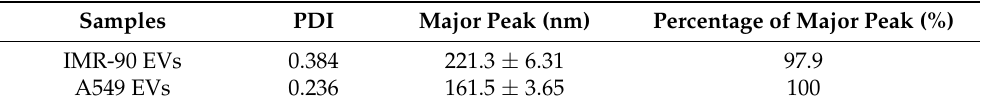
Figure 2. Characterization of EVs secreted by IMR-90 cells and A549 cells. ( A ) Negative staining TEM ( × 40,000) of EVs from IMR-90 and A549 cells cultured medium. The black solid lines represent 200 nm scale bars. ( B ) Western blot analysis of cell lysate and EVs protein from IMR-90 and A549 cells with antibodies against exosomal markers TSG101 and CD9, and endoplasmic reticulum marker Calnexin, respectively. ( C ) Size distribution of EVs analyzed by nanoparticle tracking analysis. Table 1. Characterization of EVs particle diameter distribution.